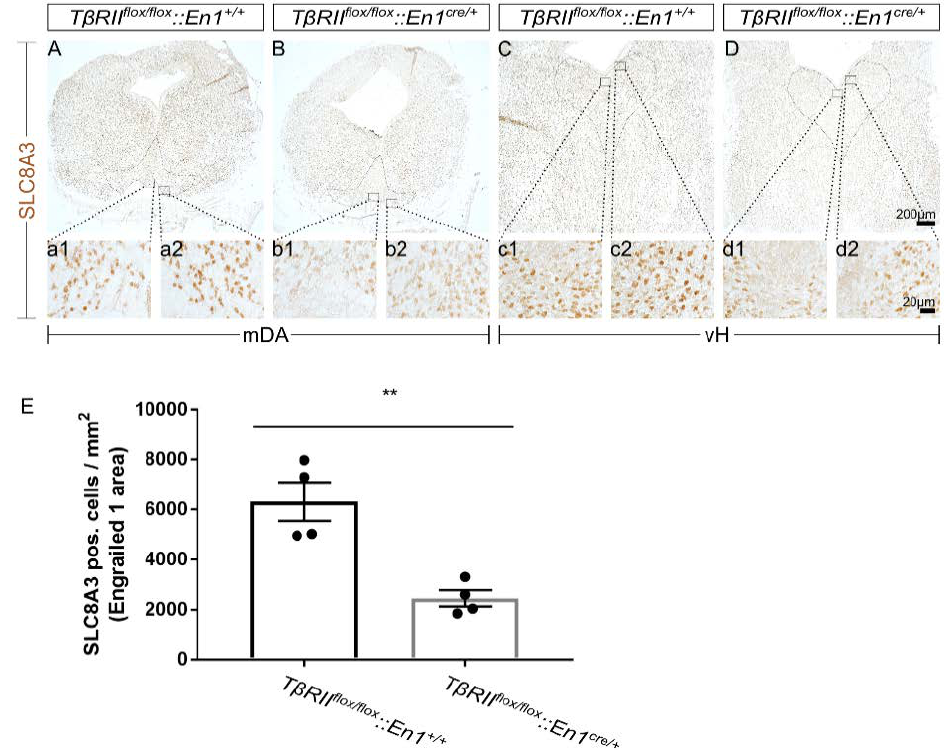
Figure 1. Impaired SLC8A3 expression by loss of TGF- β signaling. ( A – D ): Immunoperoxidase light microscopy for SLC8A3 on fixed coronal sections from the mouse midbrain ( A , B ) and ventral hindbrain (vH; C , D ) of wild type ( wt) ( A , C ) and conditional knock out ( cKO) ( B , D ) at embryonic day 16 shows a decreased labelling intensity in the area of midbrain dopaminergic neurons (a1, a2, b1, and b2 are a higher magnification of the black-boxed areas in A and B ) and hindbrain dopaminergic neurons (c1, c2, d1, and d2 are a higher magnification of the black-boxed areas in C and D ) in cKO , compared to wt . ( E ) Quantification of SLC8A3-positive cells in the Engrailed 1 area / mm 2 . ** p < 0.01, using the two-tailed unpaired Student’s t -test, n = 4/genotype).